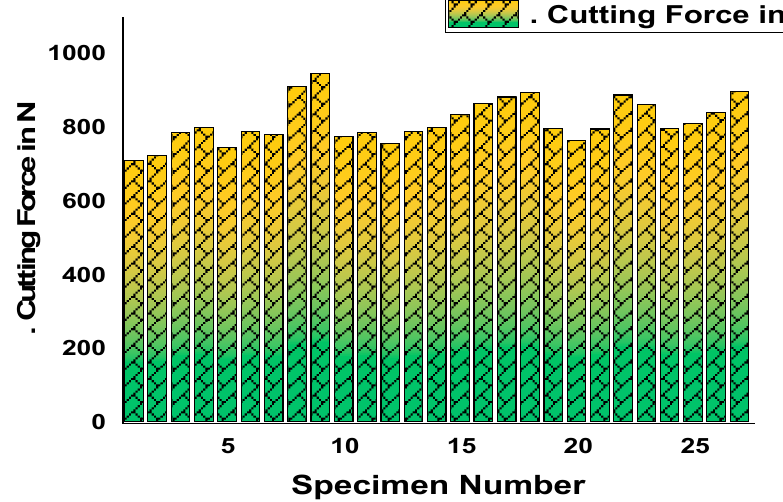
Figure 23. Surface roughness (µm) for each specimen.